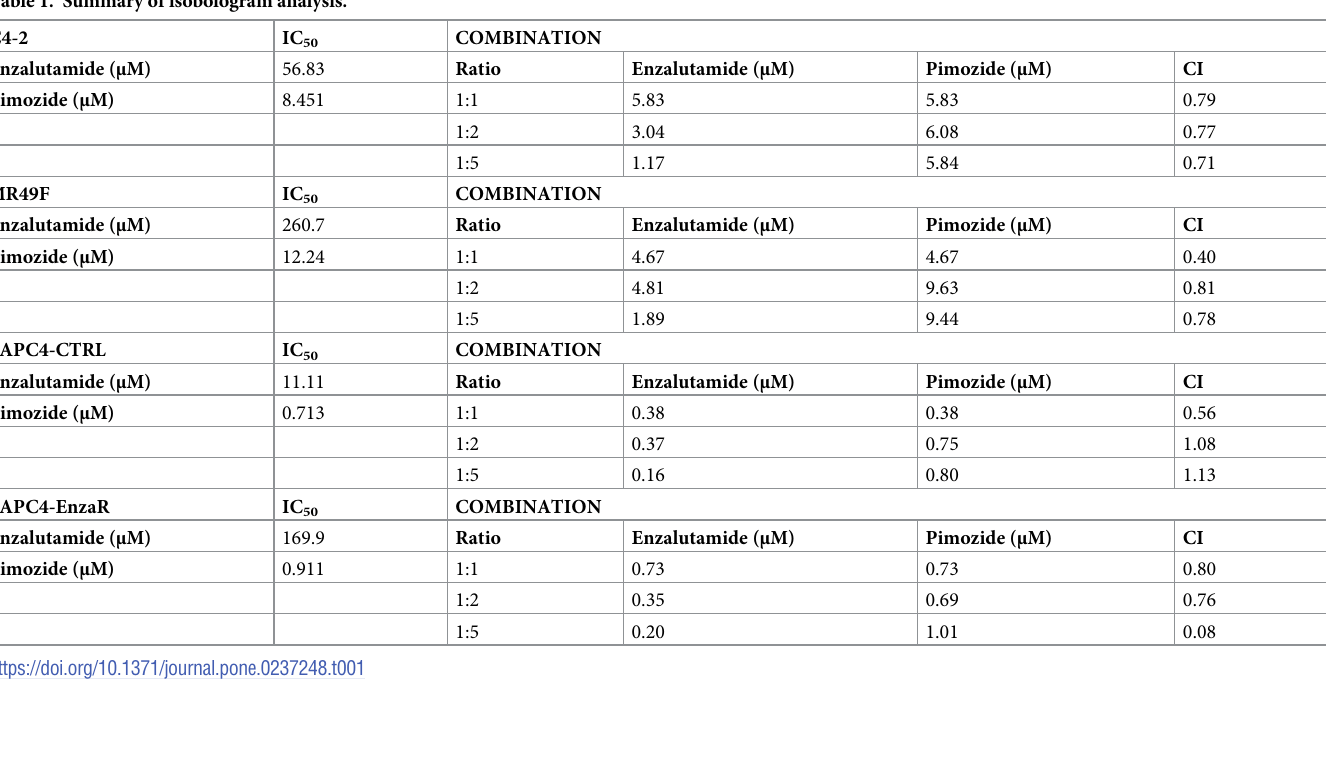
PLOS ONE | https://doi.org/10.1371/journal.pone.0237248 August 13,